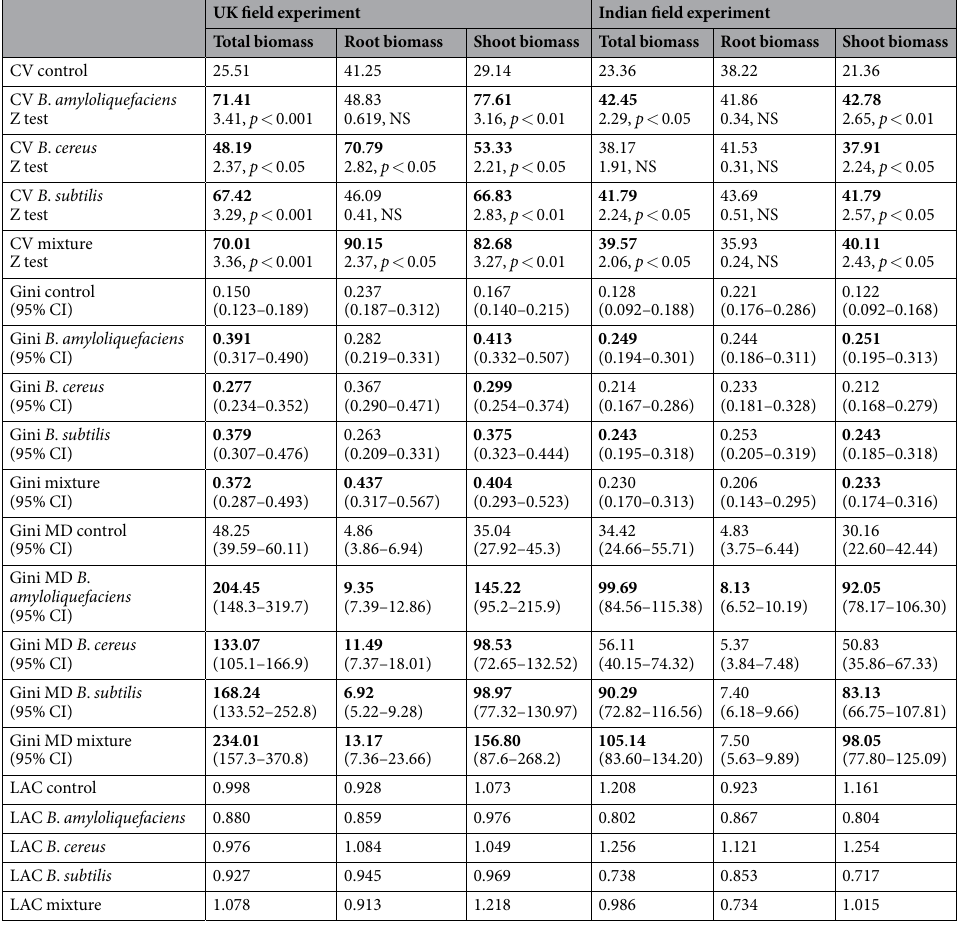
Table 2. Measures of inequality for calabrese plants grown in UK and Indian field conditions, with and without the addition of PGPR. Abbreviations as in Table 1. Differences between bacterial treatments and the control are indicated in bold text. Differences in Gini Coefficients and Gini MD determined by non-overlap of confidence intervals at p = 0.05; NS = no significant